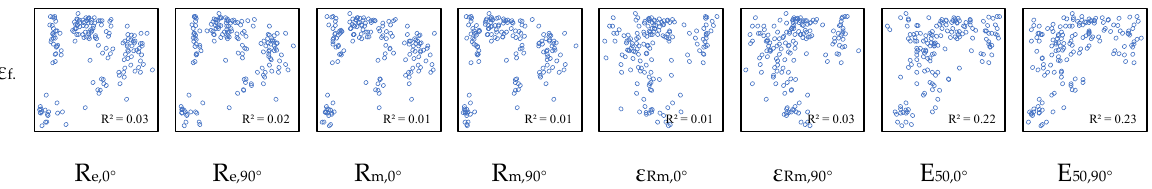
Figure 2. Distribution of the strain values at fracture, ε f , obtained for the hole expansion tests. The relationships between the fracture strain values, ε f , in the hole expansion test and the tensile test results are shown in Figure 3. No obvious correlation was found.